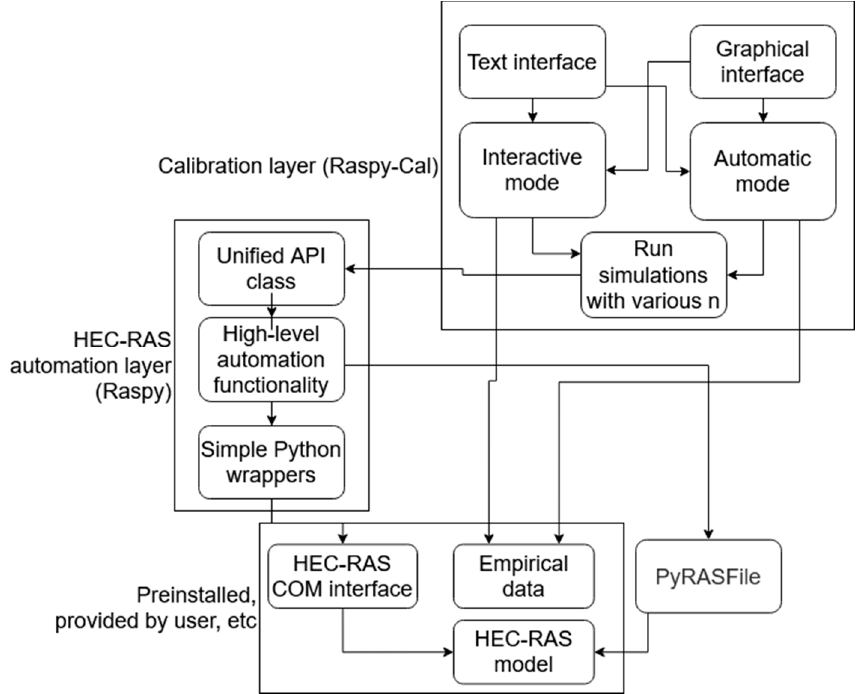
Figure 1. Raspy-Cal and Raspy architecture. PyRASFile is a set of HEC-RAS file writers and parsers for Python. The unified API class within Raspy provides a unified, abstract interface for other pro- grams (e.g., Raspy-Cal) to